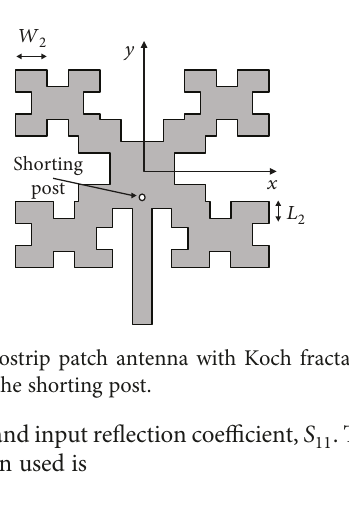
Figure 1: Microstrip patch antenna with (a) Koch fractal contour of level k = 0 (initiator), (b) Koch fractal contour of level k = 1 , and (c) Koch fractal contour of level k = 2 .